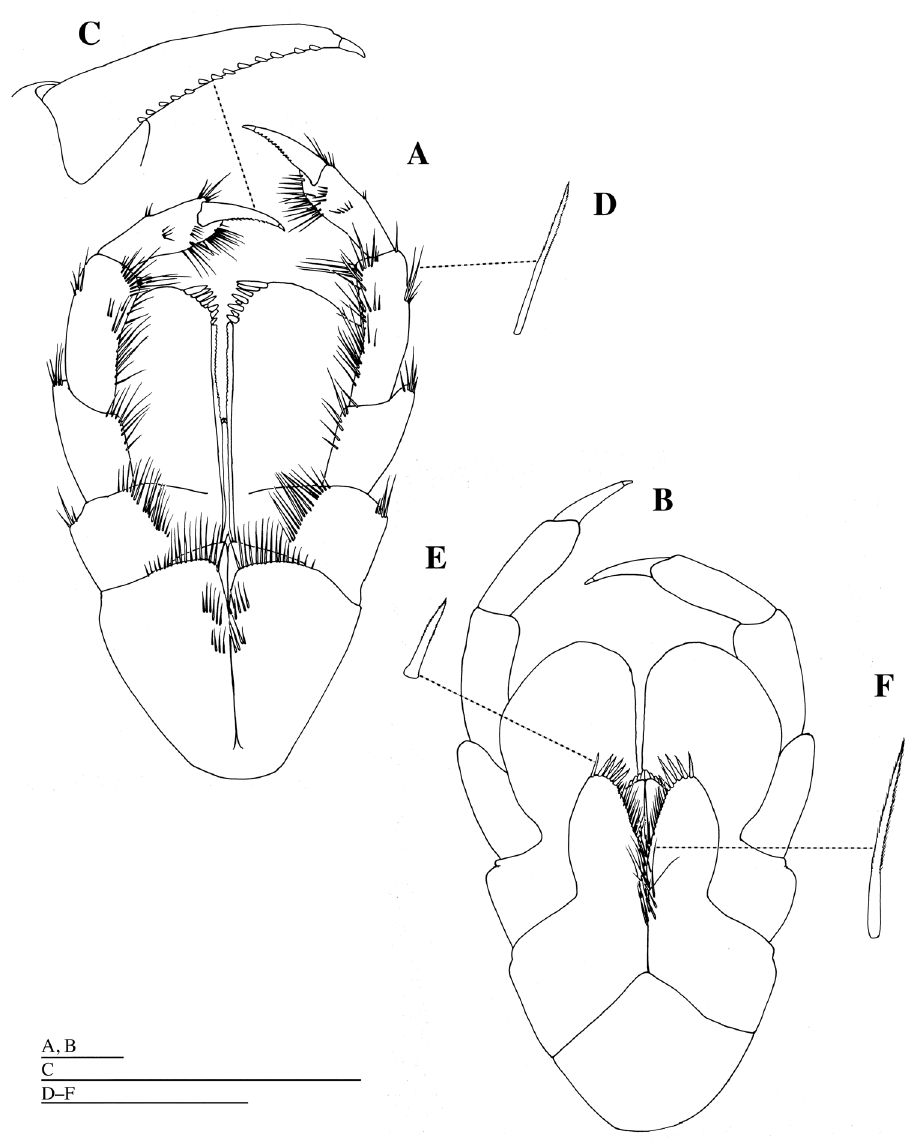
Figure 5. Epimeria abyssalis sp. n., holotype female: A left maxilliped, ventral B left maxilliped, dorsal (omitted setae excluding setae on inner plates), dorsal C article 4 of left maxillipedal palp, ventral D seta on article 2 of left maxillipedal palp, ventral E seta on inner plate of left maxilliped, dorsal F seta on inner plate of left maxilliped, dorsal. Scale bars: 1